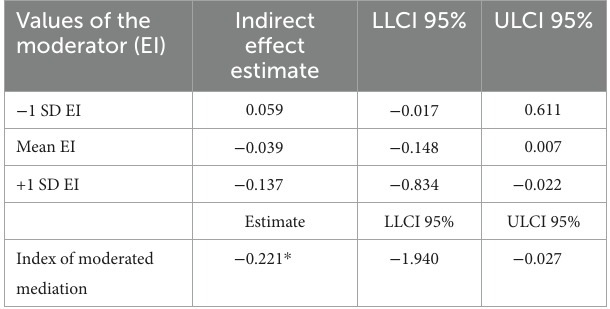
TABLE 4 Test of moderated mediation.